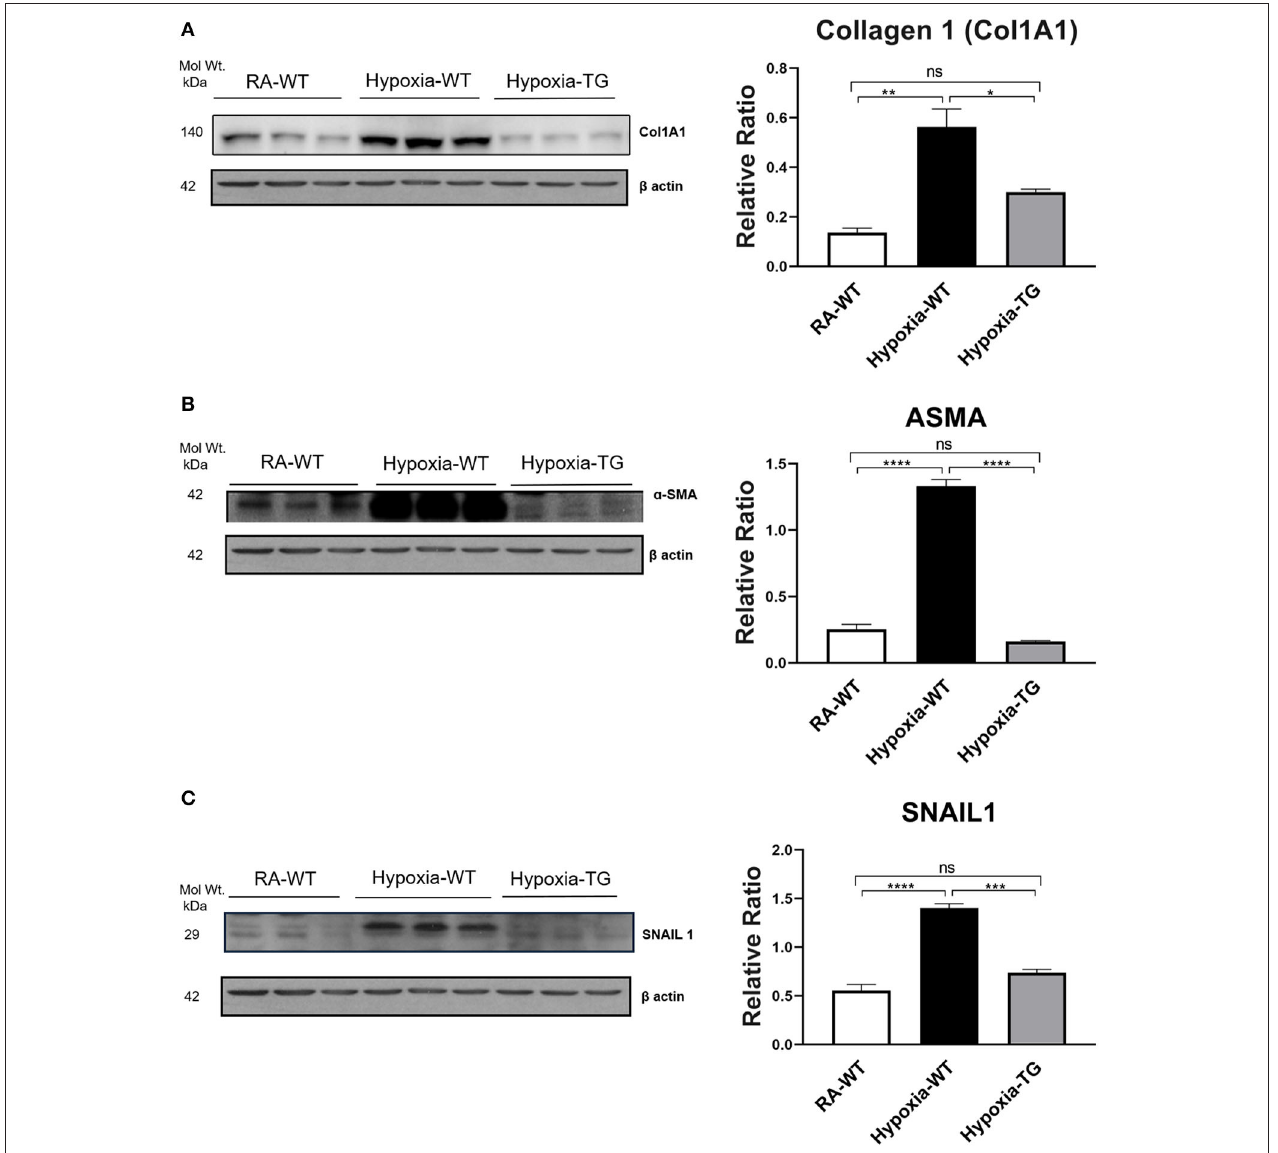
FIGURE 2 | Western blot analysis of markers of fibrosis—Collagen 1, ASMA, and SNAIL. Adult mice (C57B6) (WT) and EC-SOD transgenic mice (TG) were exposed to FiO 2 10% hypoxia for 21 days (WT). Room air animals were used as control group (RA). WB analysis was used to assess protein levels of Collagen 1 (A) , ASMA (B) , and SNAIL (C) in the right ventricular tissue. All experiments n = 3. Data represents mean ± SEM. * P < 0.05, ** P < 0.01, *** P < 0.001, **** P <